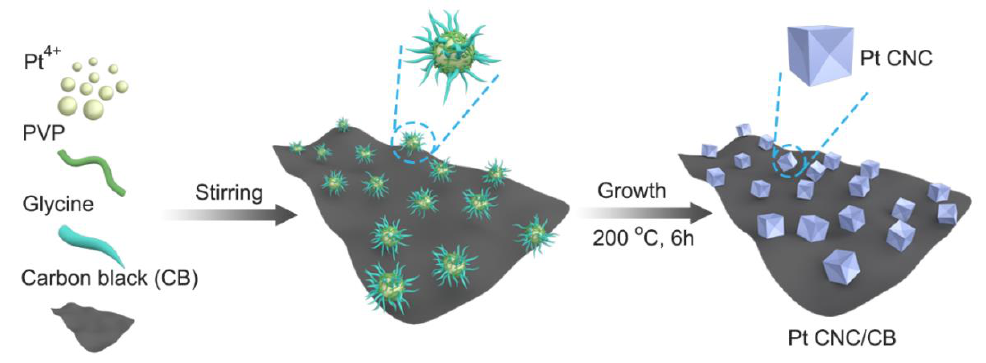
Figure 1. Schematic illustration of the synthesis of the Pt CNC/CB catalyst.